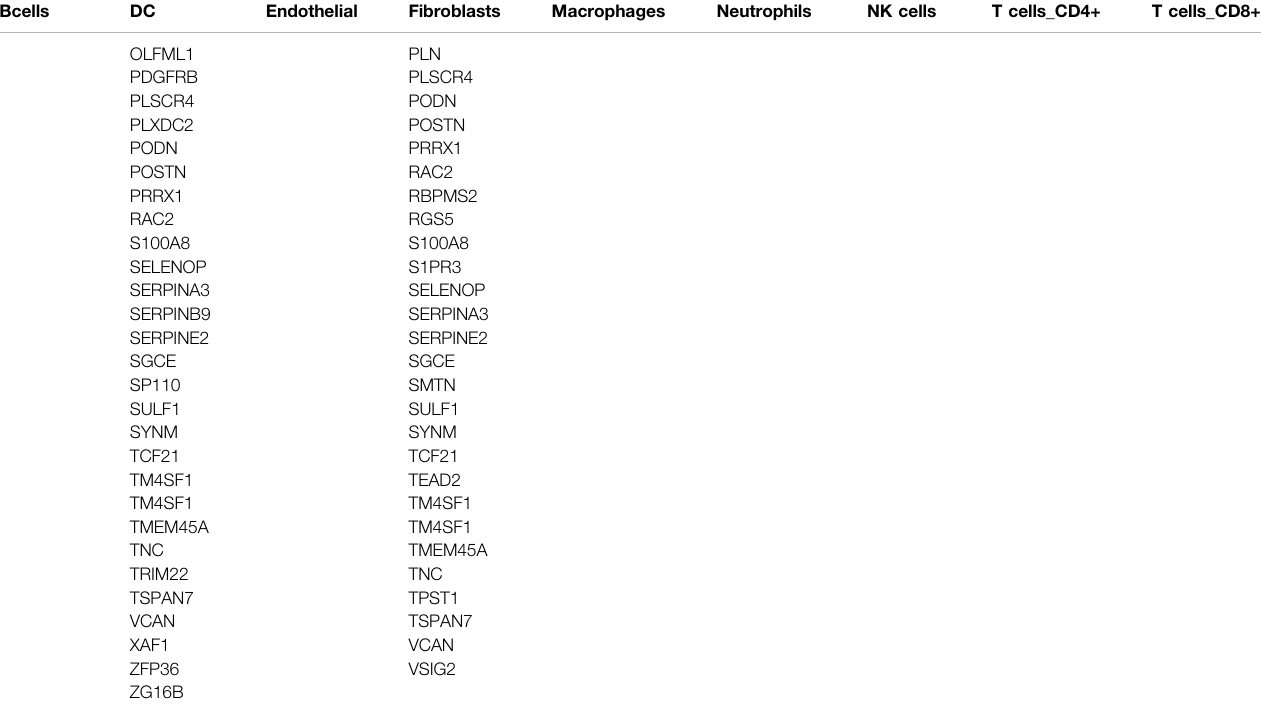
TABLE 2 | ( Continued ) List of biomarker genes representing the nine tumor-in fi ltrating candidate immune cells.